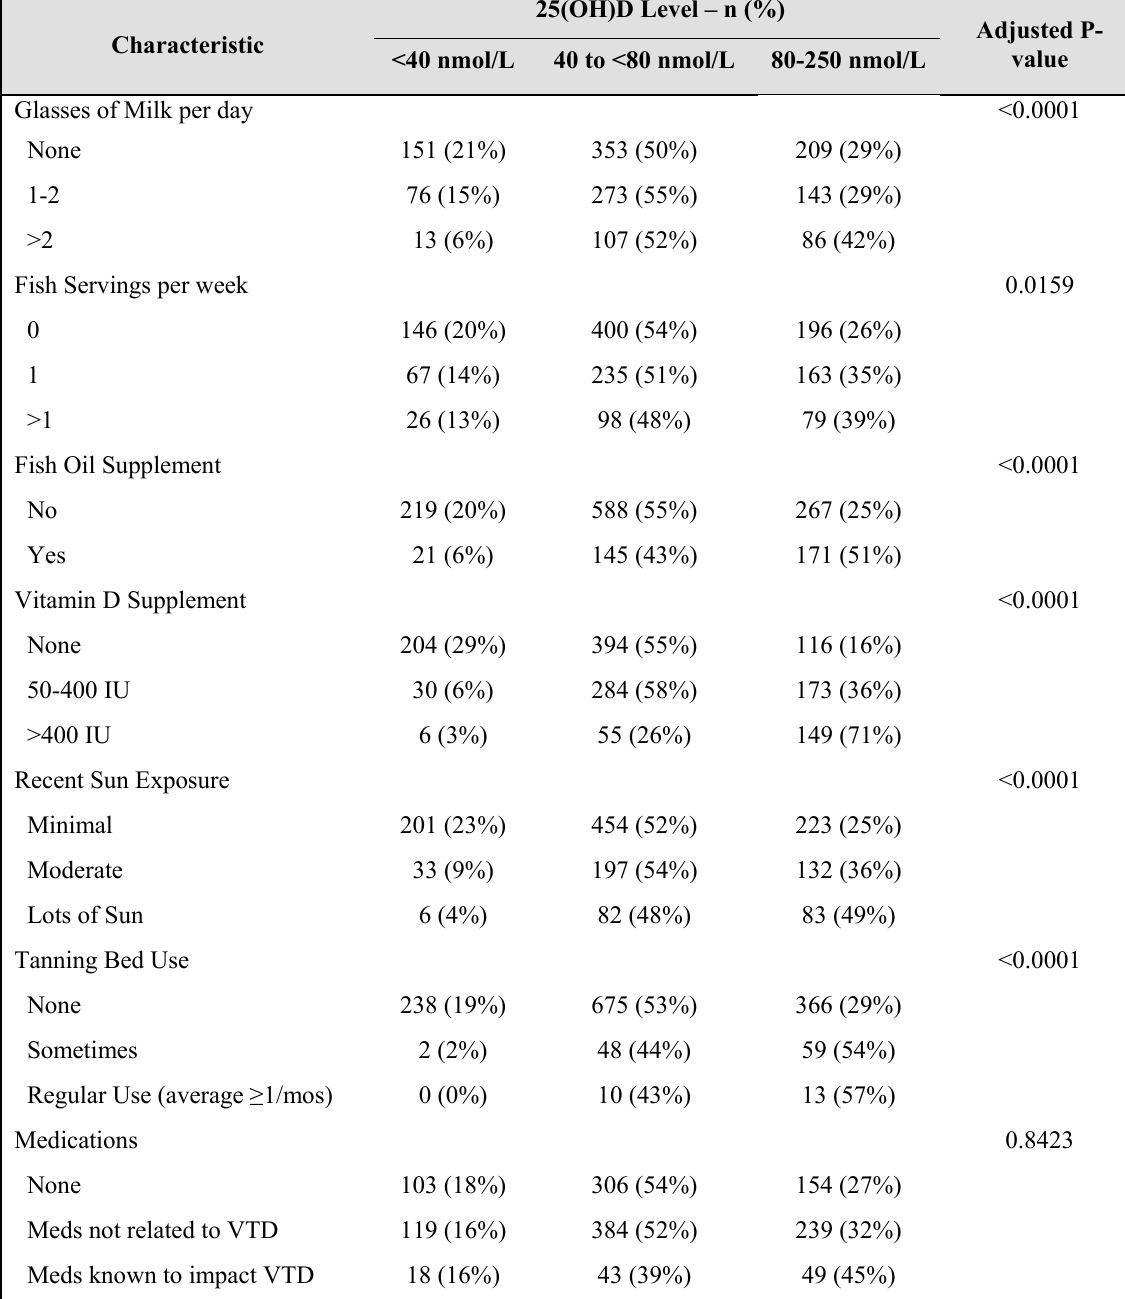
Table 4. Vitamin D Status by Lifestyle